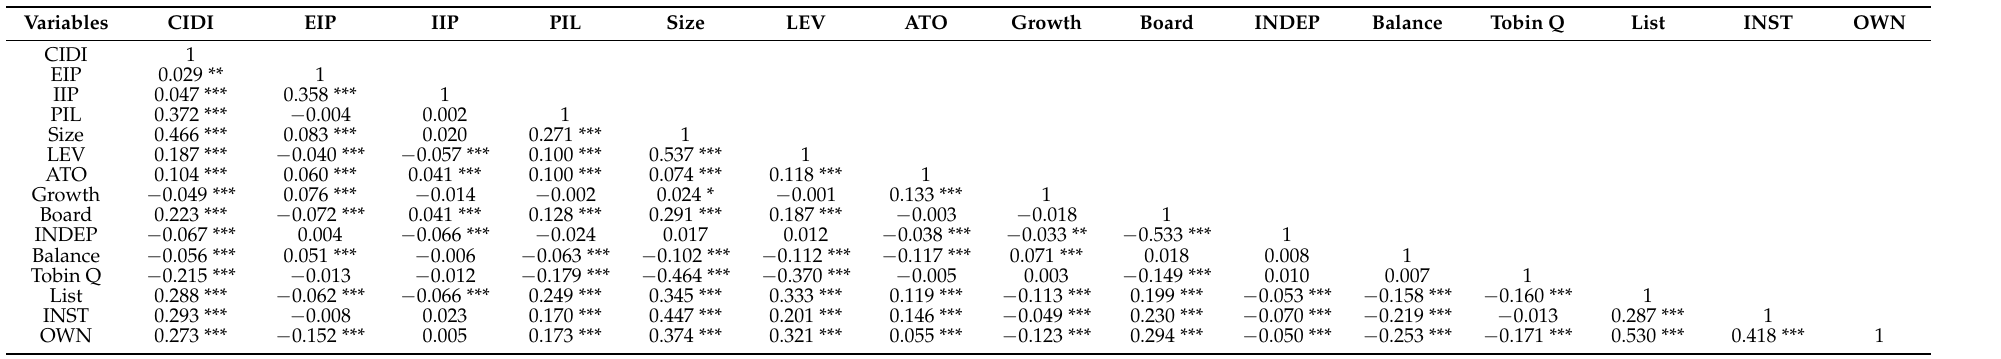
Table 4. Correlation analysis